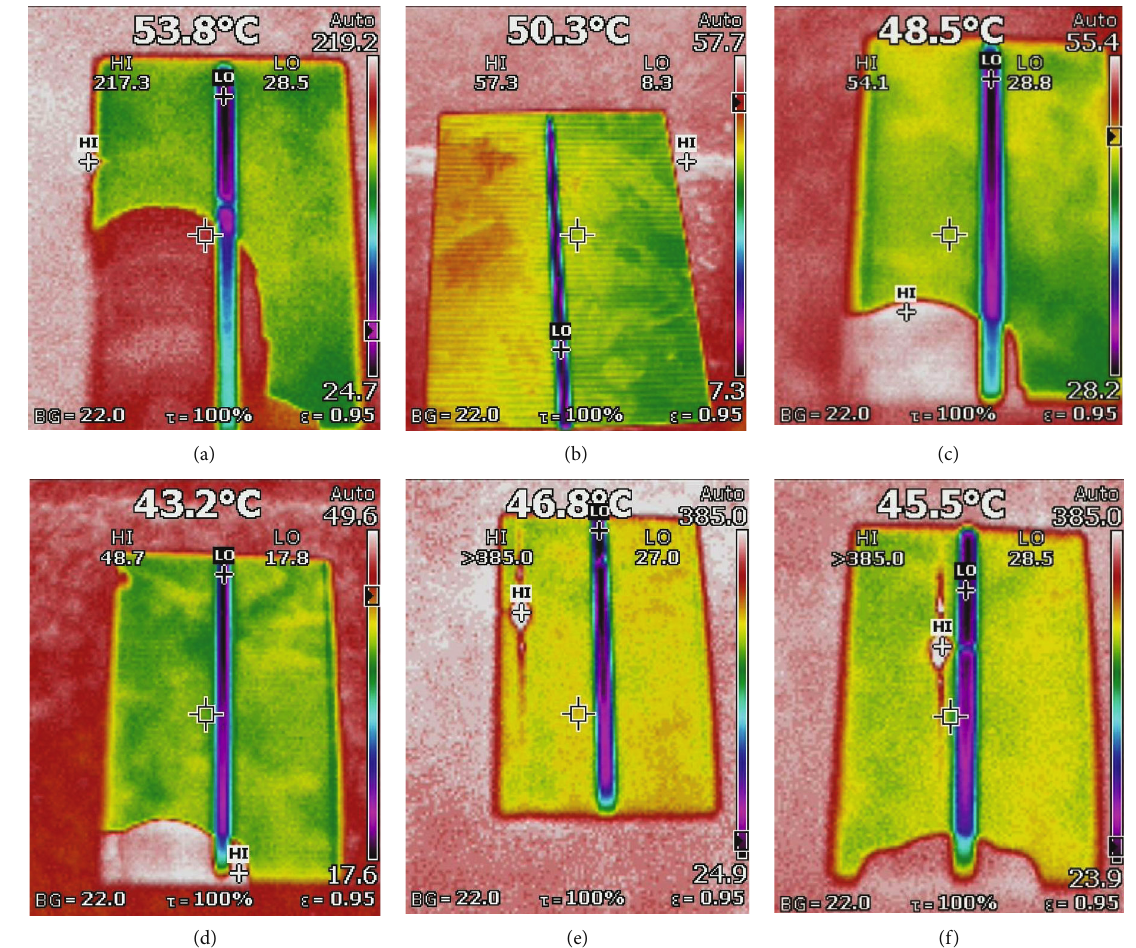
Figure 14: Temperature analysis under controlled source environment: (a) A-I (uncoated solar cell), (b) A-II, (c) A-III, (d) A-IV, (e) A-V, and (f)